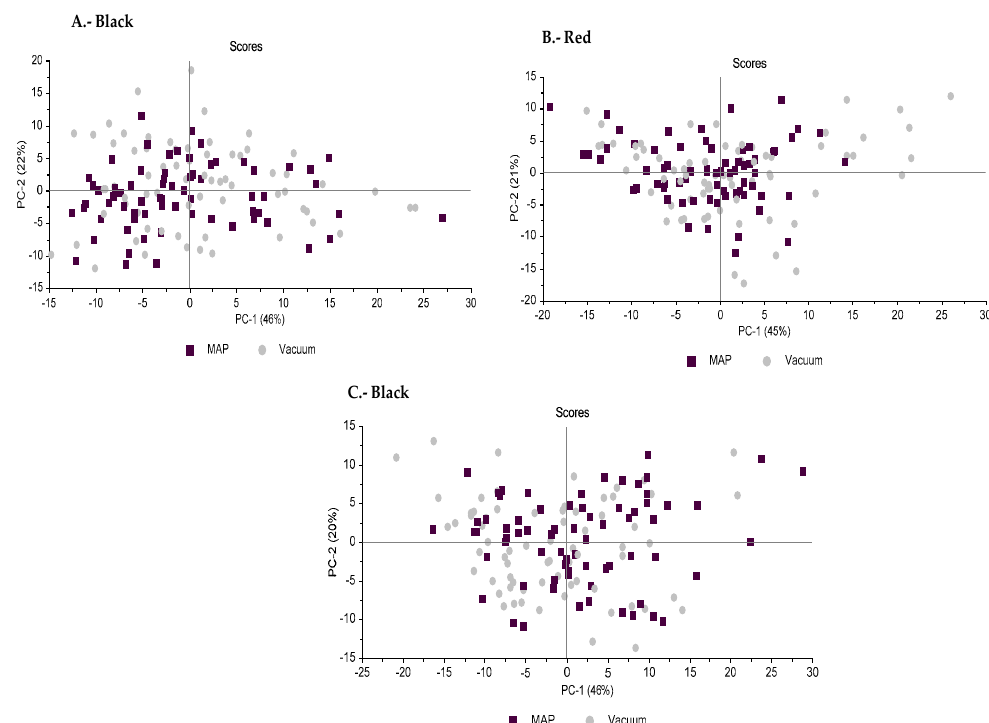
Figure 2. Principal component analyses (PCA) of Iberian dry-cured ham from two packaging format (vacuum and MAP) of three commercial categories: Black ( A ); Red ( B ); and White ( C ). Sampling grouping by type of packaging: Vacuum (grey markers) and MAP (black markers). ( A ) PCA of Black category, using ( − ) C16:0, ( − ) C18:0, C18:1 n-9 and C18:2 n-6 (PC1) and a*, Chroma, ( − ) lipid oxidation and ( − ) C18:3 n-3 (PC2). ( B ) PCA of Red category, using ( − ) L*, C16:0, C18:0 and ( − ) C18:1 n-9 (PC1) and ( − ) lipid oxidation, C18:2 n-6 and C18:3 n-3 (PC2). ( C ) PCA of White category, using C16:0, ( − ) C16:1, C18:0 and ( − ) C18:1 n-9 (PC1) and L*, b*, Hue and C18:2 n-6 (PC2).